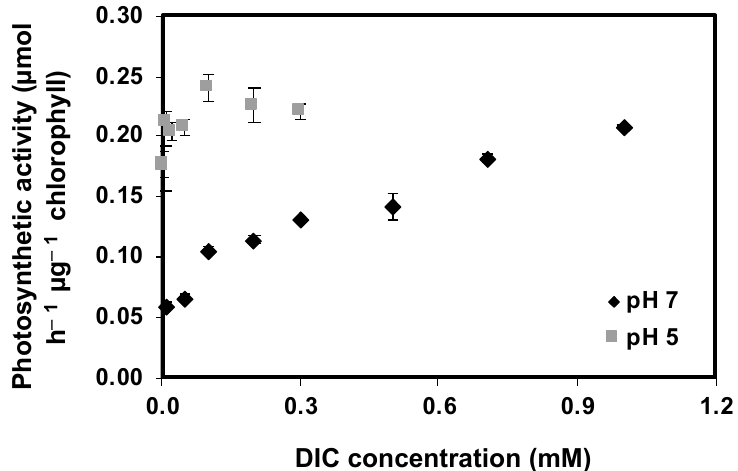
Figure 4. Photosynthetic activity curves of Chlorella sorokiniana at pH 7.0 and pH 5.0, as a function of the DIC concentration.